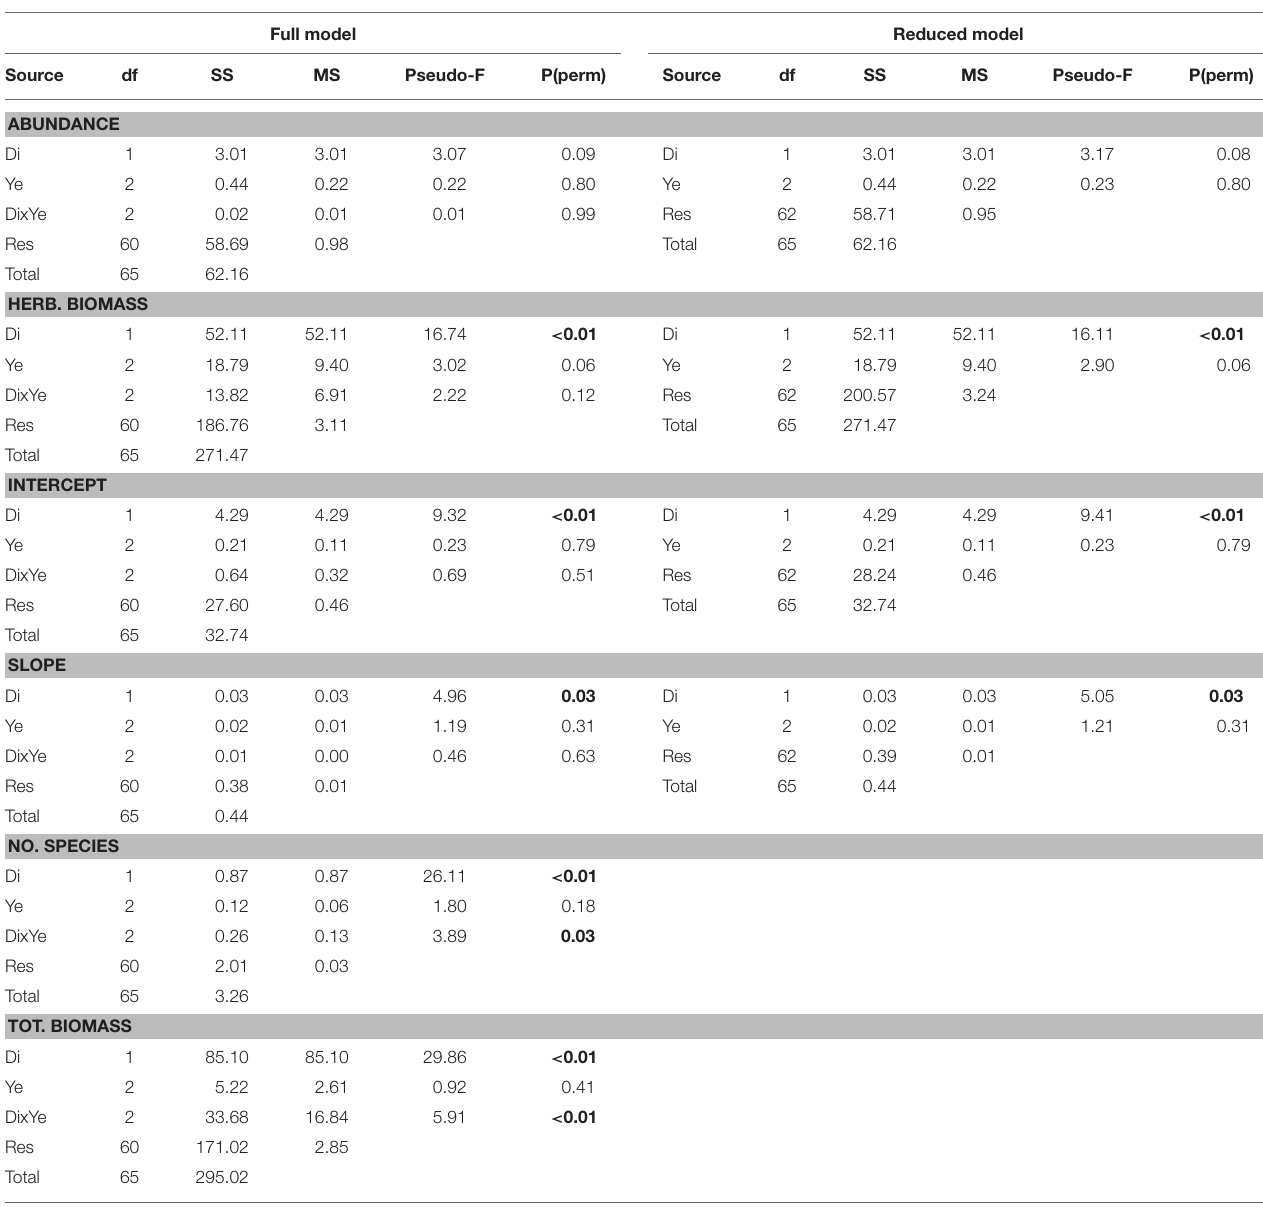
TABLE 1 | Results of PERMANOVA with distance (Di) as covariate of fish community indices. Full